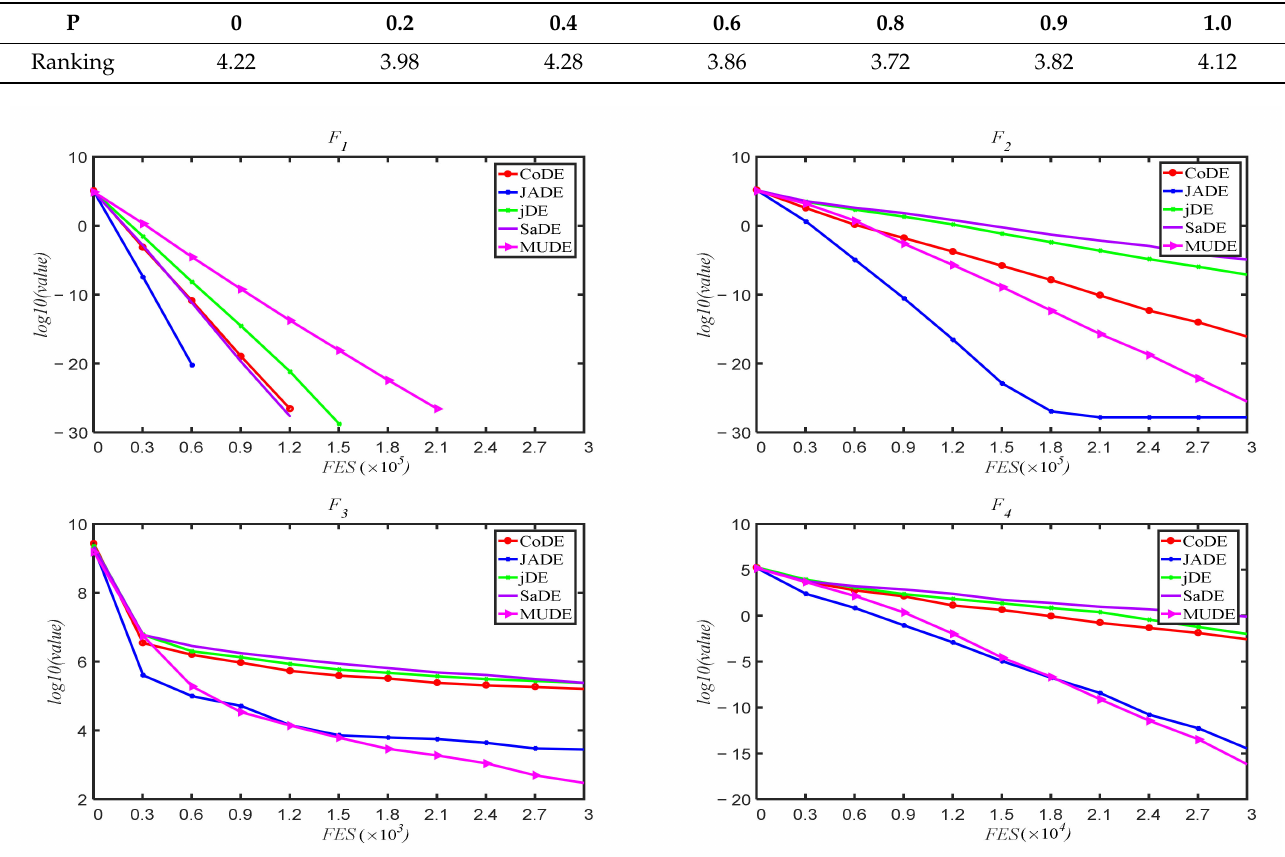
Table 4. Average ranking different of probabilistic P based on Friedman’s test.